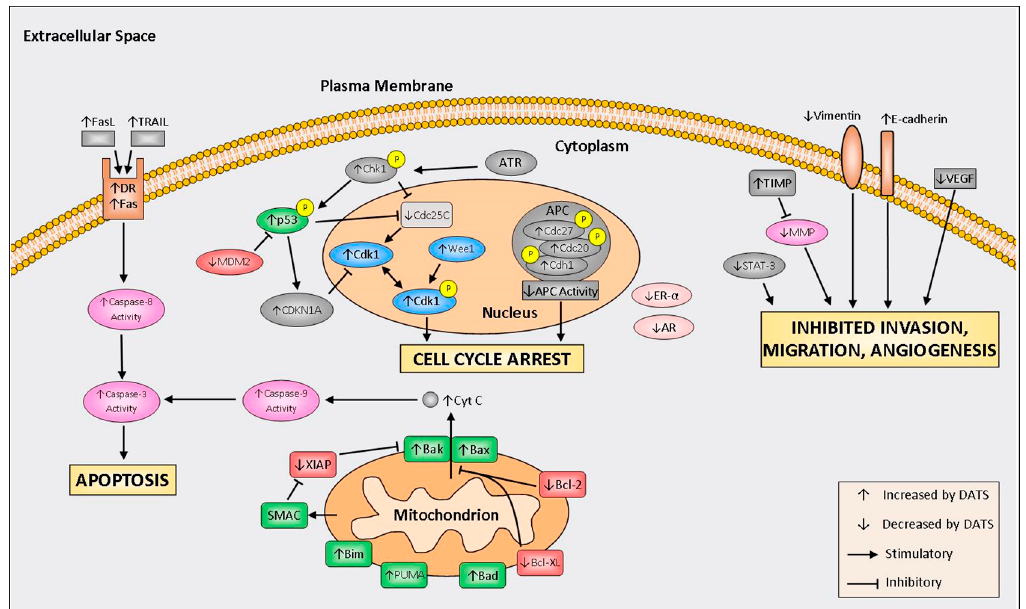
Figure 2. Summary of molecular mechanisms regulated by diallyl trisulfide (DATS). FasL, Fas ligand; TRAIL, TNF-related apoptosis-inducing ligand; DR, death receptor; ATR, ataxia telangiectasia and Rad3-related protein; MDM2, mouse double minute 2 homolog; Chk1, checkpoint kinase 1; CDKN1A, cyclin dependent kinase inhibitor 1A; Cdk1, cyclin-dependent kinase 1; Cdc25c, cell division cycle 25C; APC, anaphase promoting complex; XIAP, X-linked inhibitor of apoptosis protein; SMAC, second mitochondria-derived activator of caspases; Bim, Bcl-2-like protein 11; PUMA, p53 upregulated modulator of apoptosis; Bad, Bcl-2-associated death promoter; Bcl-XL, B-cell lymphoma-extra large; Bcl-2, B-cell lymphoma 2; Bax, bcl-2-like protein 4; Bak, Bcl-2 homologous antagonist; ER- α , estrogen receptor alpha; AR, androgen receptor; TIMP, tissue inhibitor of metalloproteinase; MMP, matrix metalloproteinase; STAT-3, signal transducer and activator of transcription 3; and VEGF, vascular endothelial growth factor.